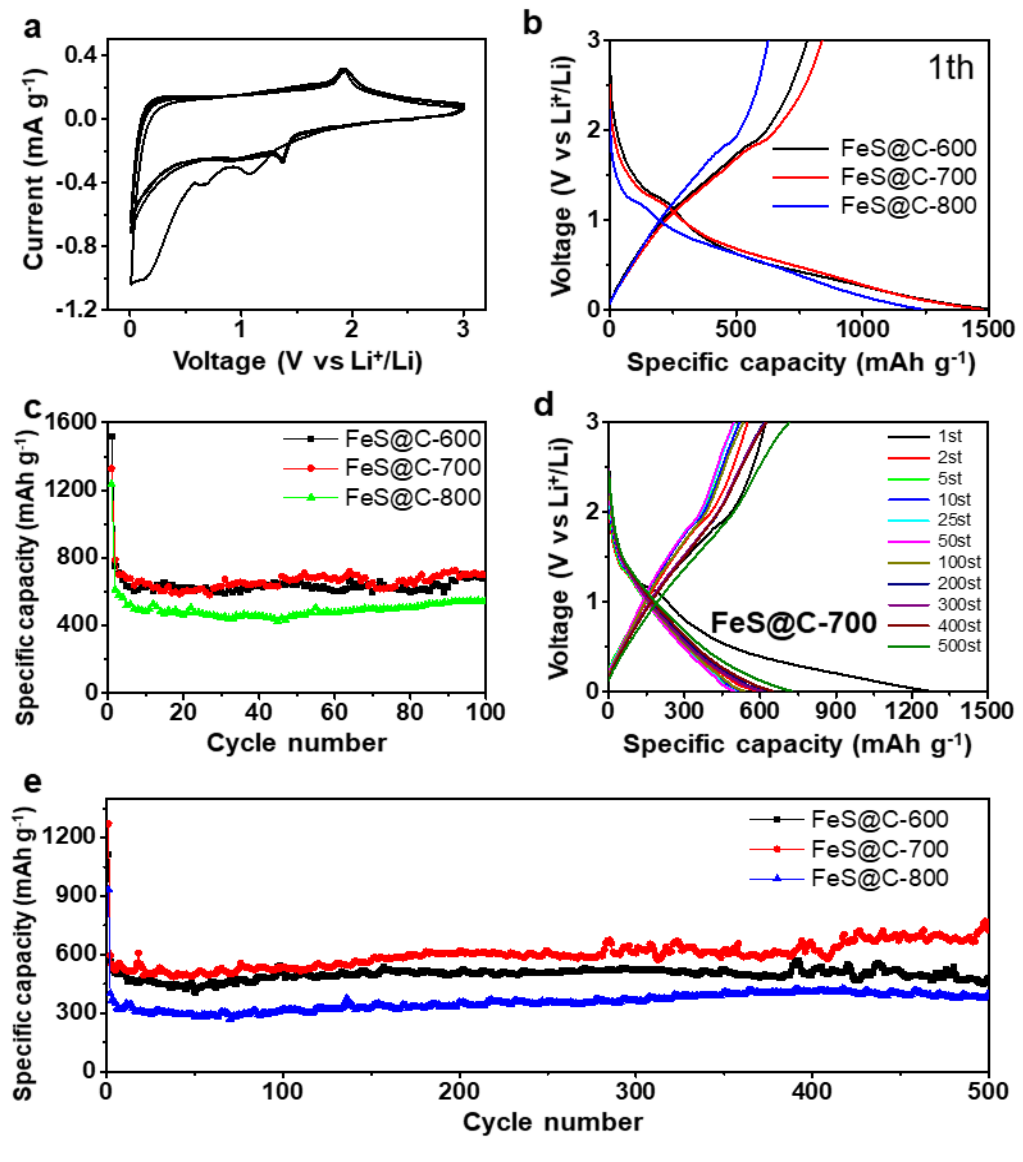
Figure 4. ( a ) Representative cyclic voltammograms of FeS@C-700 electrodes at a scan rate of 0.02 mV s − 1 . ( b ) First charge / discharge profiles of FeS@C-600, FeS@C-700, and FeS@C-800 electrodes at a current density of 100 mA g − 1 . ( c ) Cycle performance of FeS@C-600, FeS@C-700, and FeS@C-800 electrodes at a current density of 100 mA g − 1 . ( d ) Charge / discharge profiles of the FeS@C-700 electrode at a current density of 500 mA g − 1 . ( e ) Long cycling stability of FeS@C-600, FeS@C-700, and FeS@C-800 electrodes at a current density of 500 mA g − 1 . The mass loading of the three electrodes is over 1.0 mg cm − 2 .